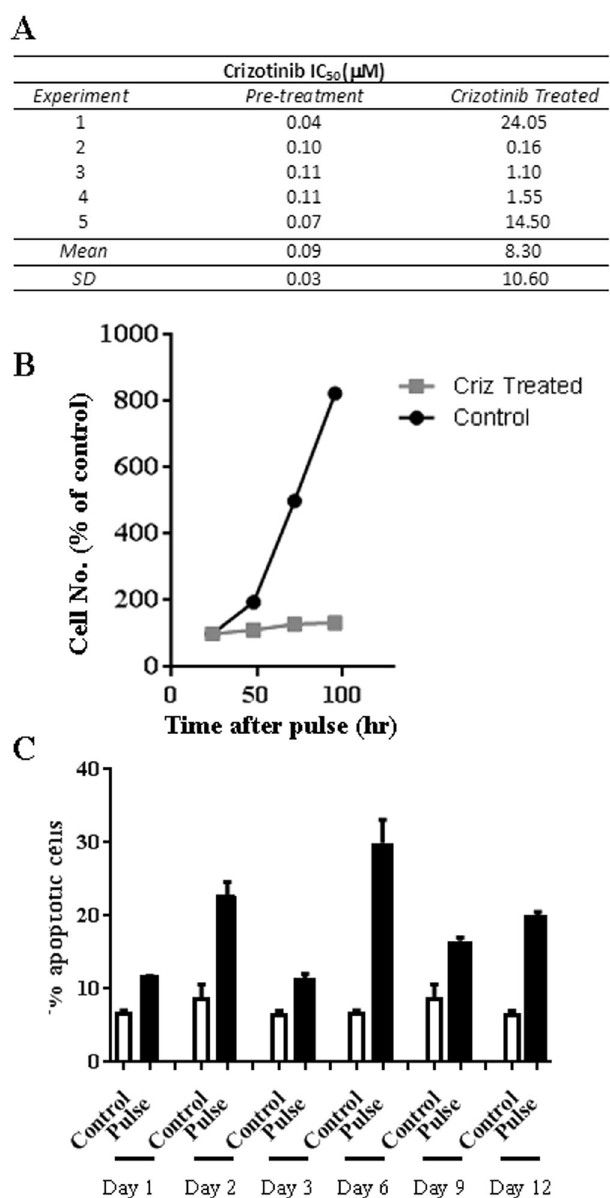
Figure 2. Effect of 24 hr exposure of H3122 cells to crizotinib (10 μ M). ( A ) Change in IC 50 for crizotinib cytotoxicity before and 12 days after treatment in five separate experiments. ( B ) Growth rate for H3122 cells 12 days after crizotinib treatment – data shown are for the first experiment in “A”. Pulse refers to the transient crizotinib exposure. ( C ) Apoptosis in crizotinib “pulsed” cells up to 12 days after treatment (black bars) compared to control/untreated cells (white